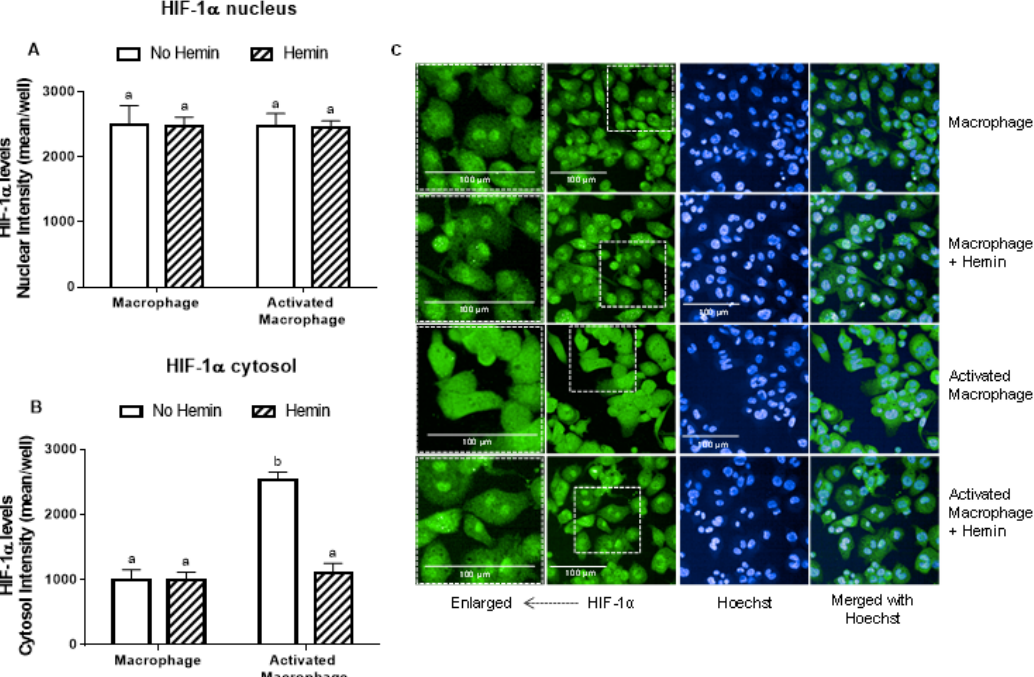
Figure 4. The increase of cytosolic HIF-1 α levels of activated macrophages is inhibited by hemin. ( A ) Nuclear and ( B ) cytosolic HIF-1 α levels and ( C ) representative images of macrophages and activated macrophages, in the absence or presence of 10 µ M hemin for 72 h. HIF-1 α levels were detected by immunofluorescence using a confocal imaging system (Opera Phenix, Perkin Elmer). Images were acquired with 20 × water objective. Staining intensity levels in the nucleus and cytosolic region were obtained using Harmony software (Perkin Elmer). Nucleus and cytosol were identified through Hoechst (at 405 nm) and CellMask (at 655 nm) staining, respectively. Scale is shown as 100 µ m. White dotted frames indicate the section of the image that was enlarged. Values with different superscript letters (a and b) indicate significant differences ( p < 0.05) between groups. For all bars with the same letter, the difference between the means is not statistically significant. HIF-1 α , hypoxia-inducible factor-1 alpha.